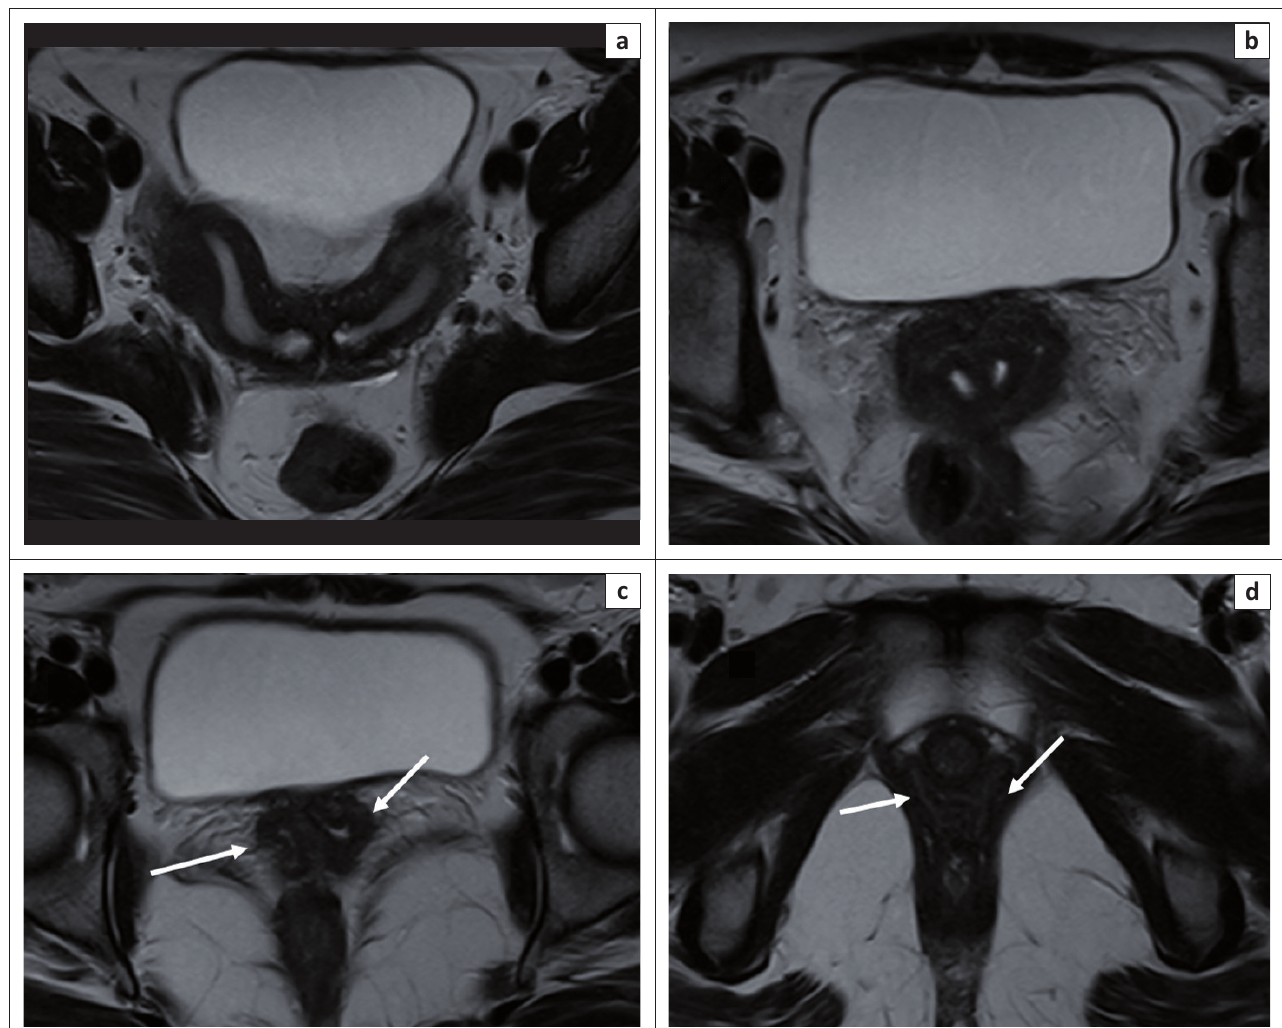
FIGURE 11: (a, b) Axial T2 sequence demonstrates a fundal external indentation exceeding 50 % of the uterine wall thickness, dividing the uterine corpus and cervix completely. (c, d) Axial T2 sequence demonstrates two vaginal cavities (white arrows). classified into subtypes a and b by the presence or absence (Figure 14) of a functional cavity in the contralateral component (rudimentary horn communicating or